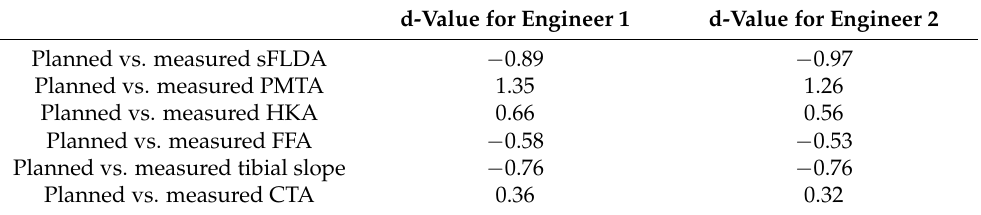
Table 5. Quantification of effect size using Cohen’s d. sFLDA: supplementary angle of the femoral lateral distal angle, PMTA: proximal medial tibial angle, HKA: hip–knee–ankle angle, FFA: